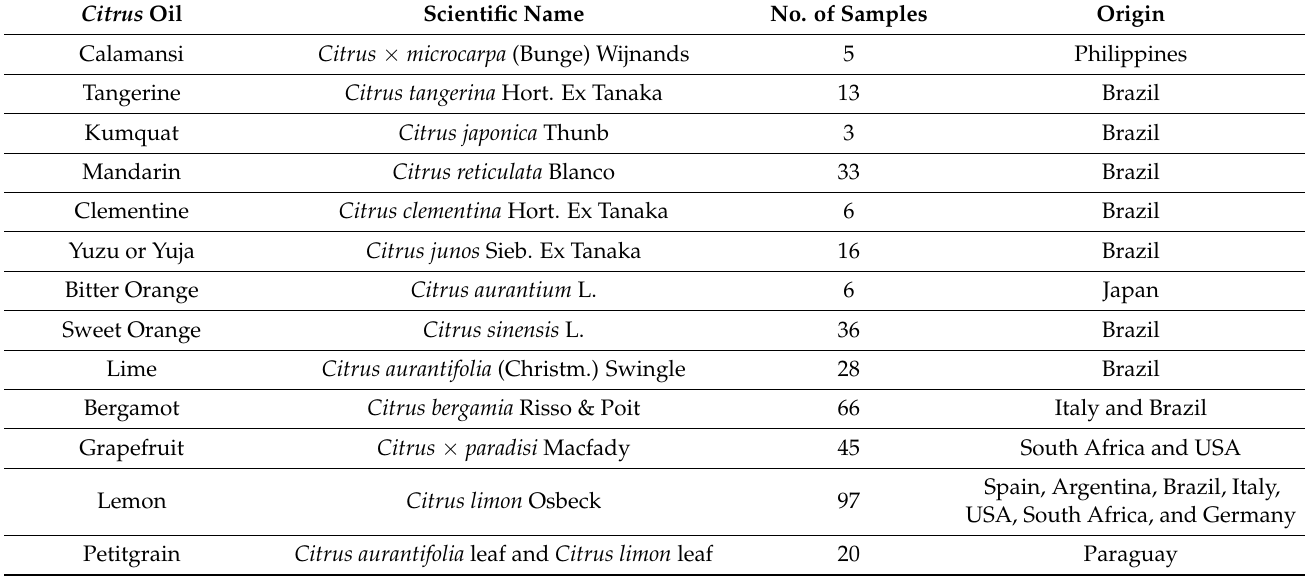
Table 4. Sample information of citrus essential oil samples from the APRC